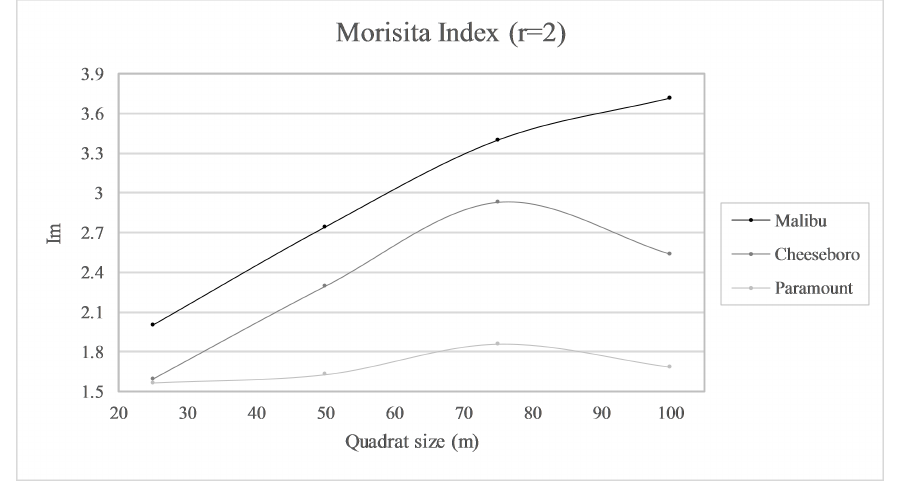
Figure 4. Morisita index for three populations at four quadrat sizes. Quadrat sizes used were 25, 50, 75, and 100 m (represented as solid-filled